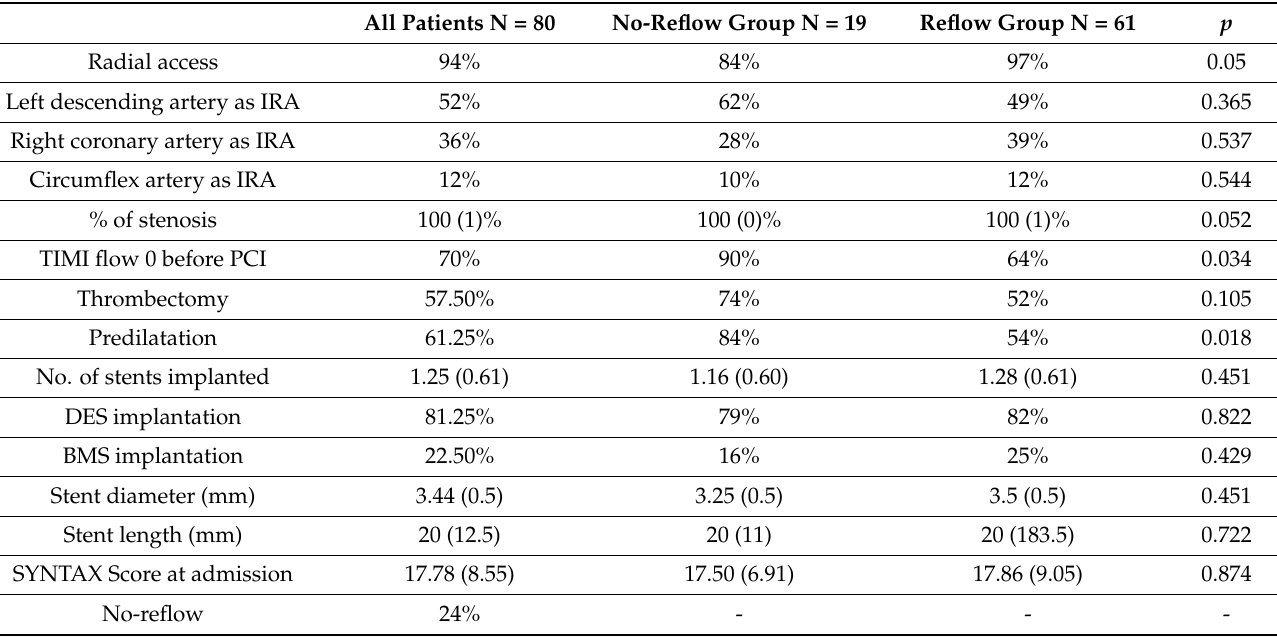
Table 2. Angiographic and procedural